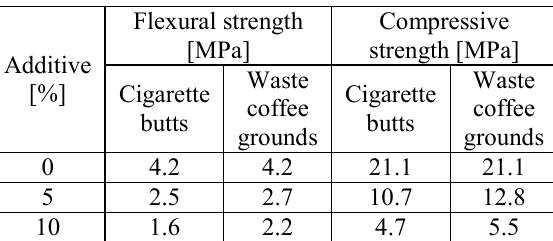
Table 7. Thermal conductivity and